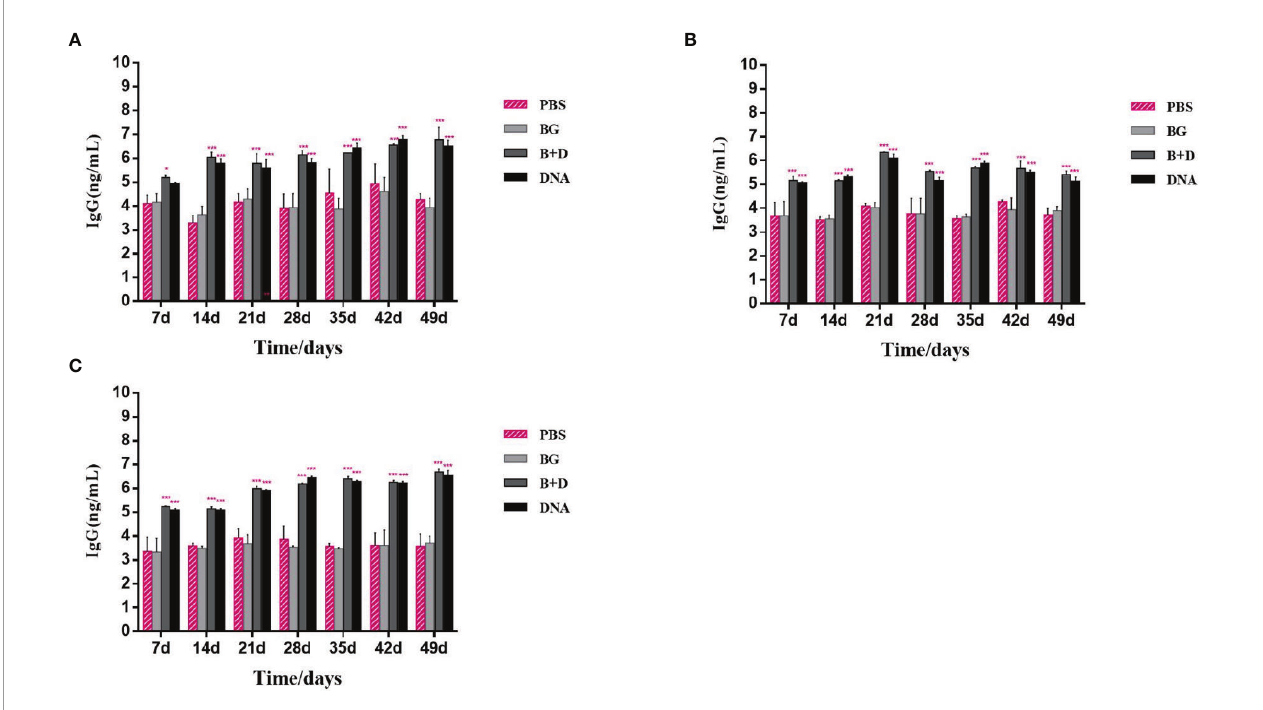
FIGURE 10 | Immunoglobulin antibodies in serum. Groups of mice were immunized (A) orally, (B) intramuscularly, or (C) intraperitoneally with pCI – PoRV – VP6, bacterial ghosts (BGs) loaded with pCI – PoRV – VP6, unloaded BGs, and PBS. Serum samples were collected on days 0, 7, 14, 21, 27 – 29, and 49. Values are expressed as the mean ± SD of four individual experiments. Signi fi cance of differences between the PBS, BG+DNA, DNA, and BG groups is represented as follows: *P < 0.05, **P < 0.01, ***P < 0.001. n.s., no signi fi